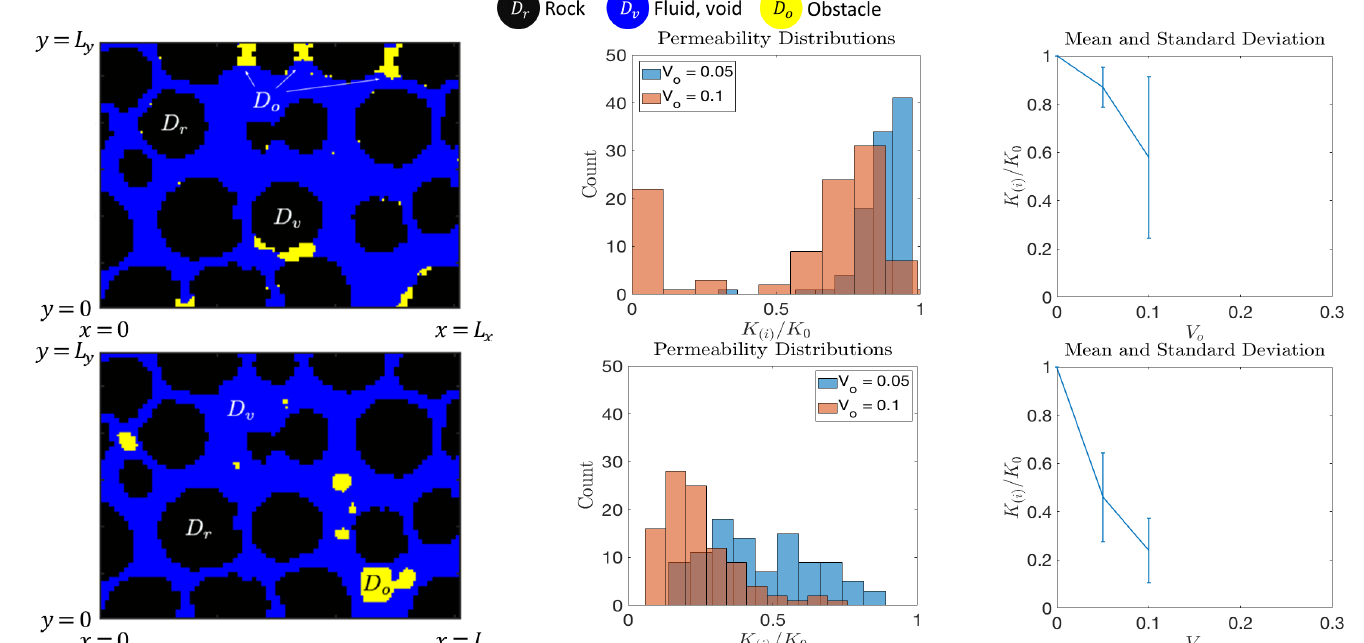
Figure 24. Flow properties with geometries D o obtained with LP model in Example 3. Top row: pore-coating, and bottom row: pore-filling geometries, Left: many-pore geometry with V o = 0.05. Middle: histogram of ( K ( i ) ) i for two values of V o . Right: mean and standard deviation of ( K ( i ) ) i for two values of V o